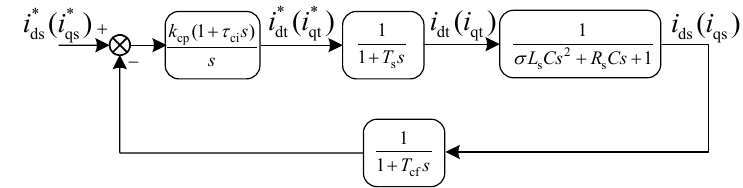
Figure 9. The control diagram of the current loop.